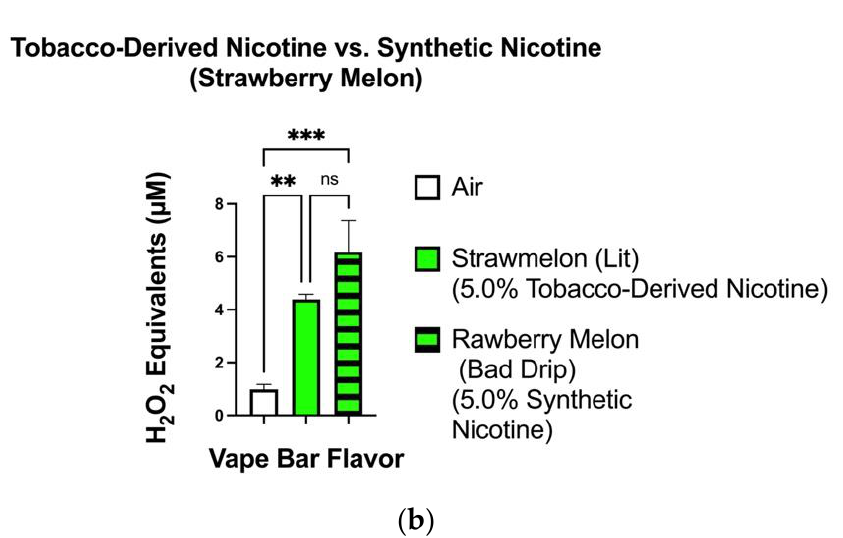
Figure 2. ROS levels within aerosols generated from blueberry-raspberry ( a ) and strawberry-melon ( b ) flavored tobacco-derived nicotine-containing and TFN vape-products. ROS levels within the generated aerosols from each individual TFN vape-product and tobacco-derived nicotine-containing vape-product was measured via spectrofluorometry and quantified as H 2 O 2 equivalents. During analysis, the level of ROS generated from each individual vape-product was compared to the ROS generated from the filtered air control. Data are represented as mean ± SEM, and significance was determined by one-way ANOVA. ** p < 0.01 and *** p < 0.001 versus air controls. ns is abbreviated for “Non-Significant” versus air-controls ( p > 0.05). Sample size (N) = 3–4. Regarding minty/iced (cooled) flavored vape products, there appear to be significant differences in ROS levels generated between TFN vape products and their corresponding flavor-specific tobacco-derived nicotine counterparts (Figure 3). The level of ROS generated from the Pachamama: Banana Ice (5.0% synthetic nicotine) vape-bar (7.19–8.40 µ M) differed significantly from that generated from the Puff Bar: Banana Ice (5.0% tobacco-derived nicotine) bar (9.69–15.87 µ M) (Figure 3a). Similarly, the level of ROS generated from aerosolized Salty Mann: Spearmint (5.0% synthetic nicotine) e-liquid (1.33–2.11 µ M) differed significantly from that generated from the Hyde: Spearmint (5.0% tobacco-derived nicotine) bar (3.28–4.50 µ M) (Figure